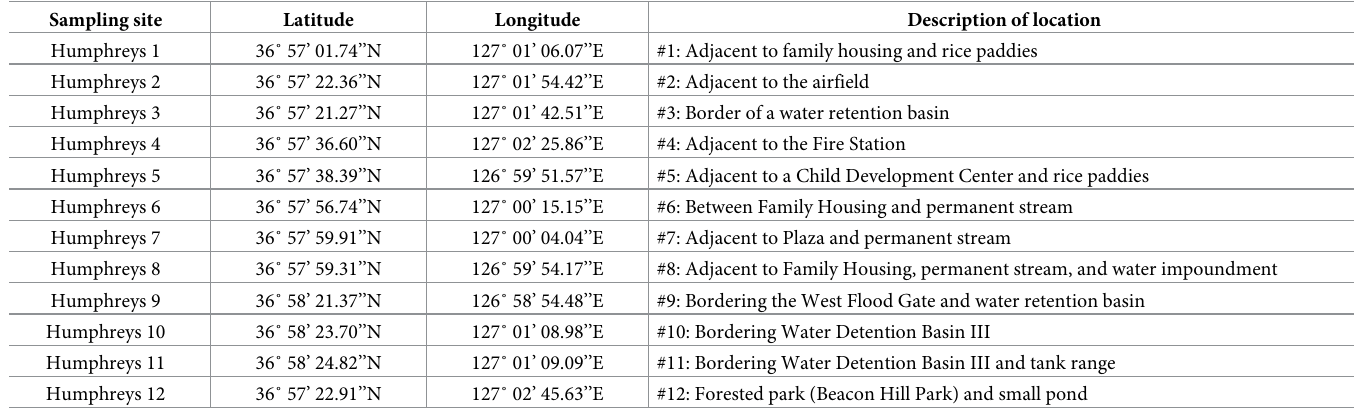
Table 1. Description of mosquito sampling sites on Camp Humphreys (see Fig 1 for general